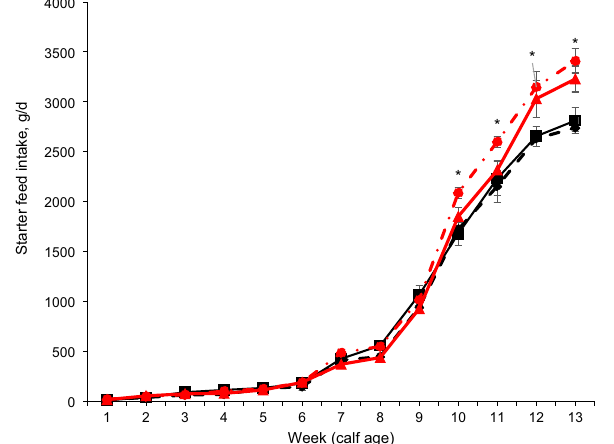
Figure 2. Starter feed intake of calves (n = 16 calves/treatment, 8 male and 8 female) with one of the following treatments: Late grouping-late hay increment (LG-LH; black filled square), late grouping-early hay increment (LG-EH; black filled diamond), early grouping-late hay increment (EG-LH; red filled triangle), and early grouping-early hay increment (EG-EH; red filled circle) during the total period of study (from 1 to 13 wk of age). Data are presented as means ± SEM. Asterisk indicate a significant difference (* P < 0.05) between groups at a given time point.